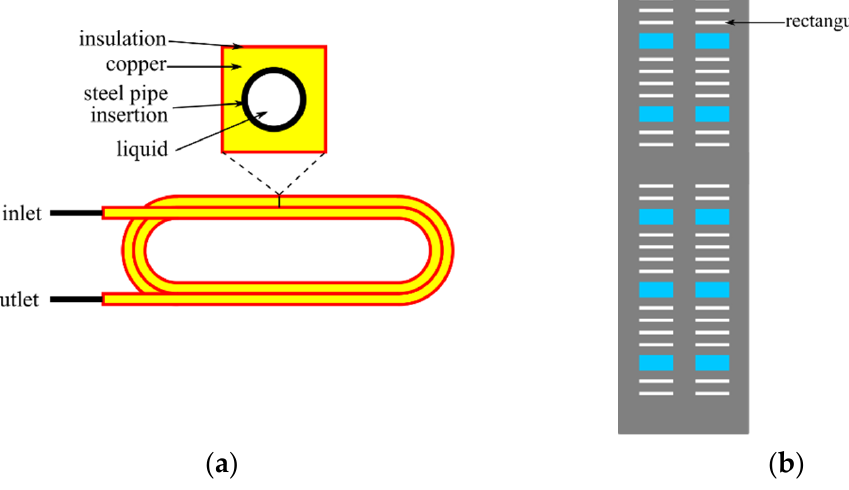
Figure 16. Windings made of hollow copper conductors: ( a ) 8 MW direct drive generator oil cooled windings [100]. The inner support base stainless steel tubes are extending out; ( b ) 777 MVA hydro- generator water cooled windings [102]. Only 12 conductors per winding are hollowed